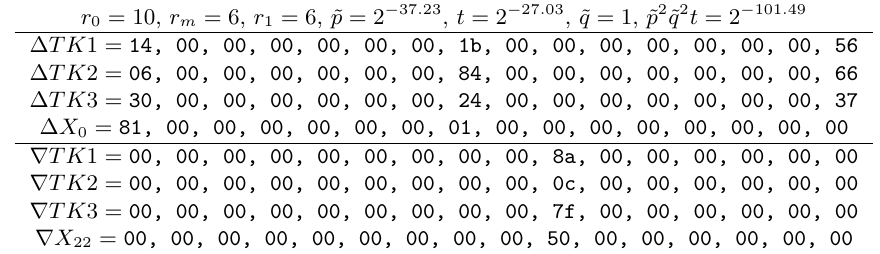
Table 7: The 22-round related-tweakey boomerang distinguisher for SKINNY-128-384